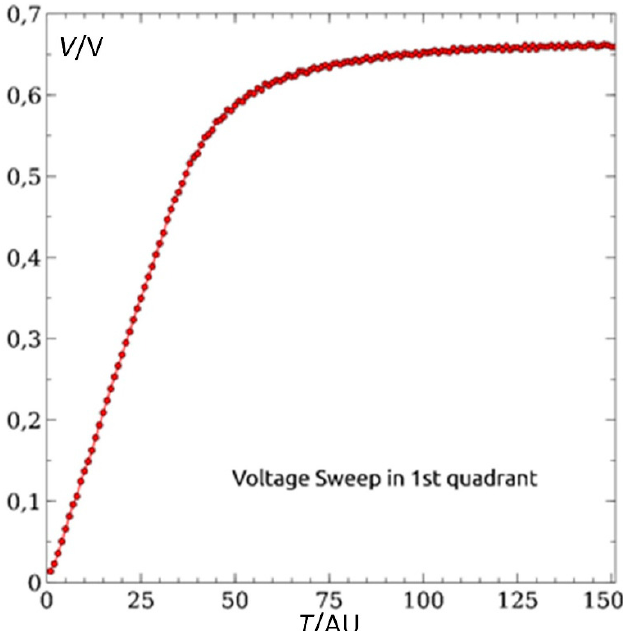
Figure 23. Voltage sweep in the first quadrant (voltage vs. time). AU: arbitrary units.